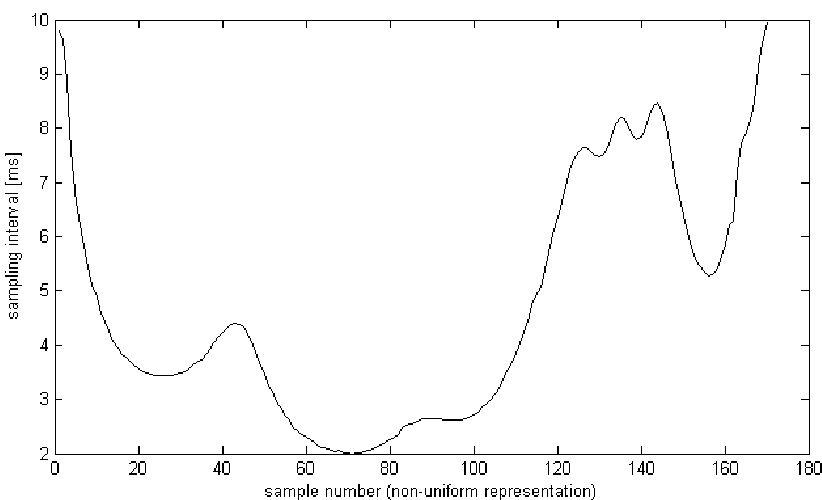
Figure 4. Interval of consecutive samples in a non-uniform representation ( f m 1 = 100 Hz) calculated for the reference beat from file CSE001.